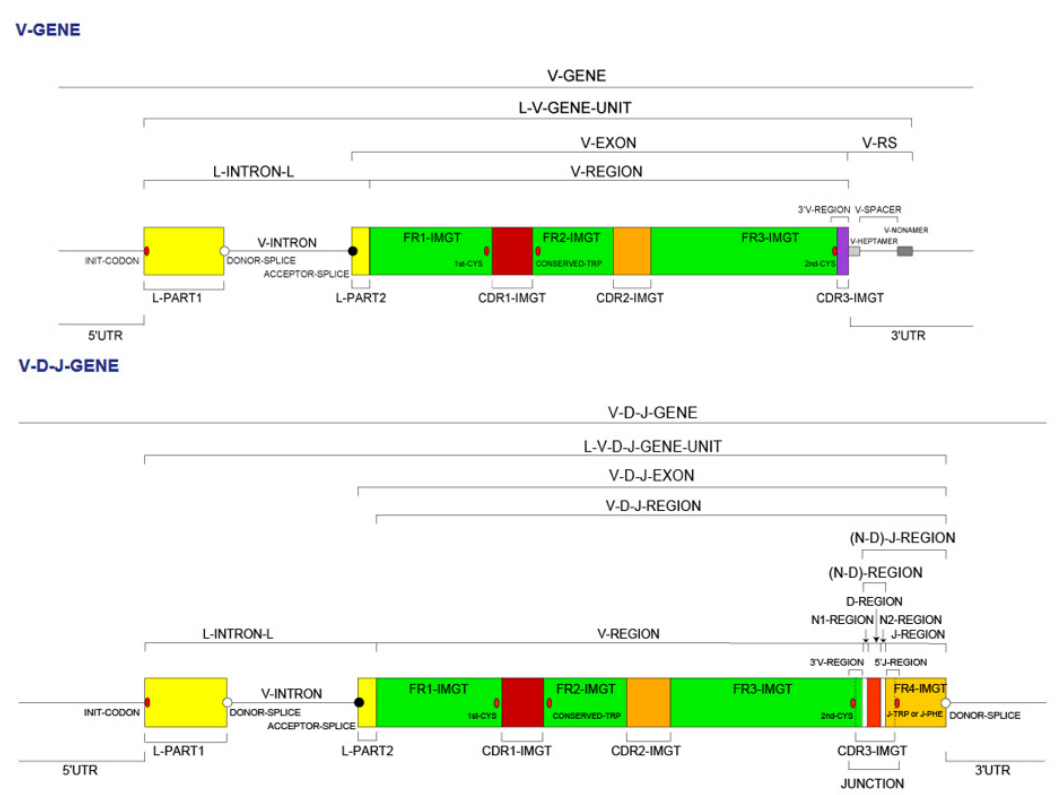
Figure 14. Description of a V ‐ GENE and of a V ‐ D ‐ J ‐ GENE (DESCRIPTION axiom) [34,35]. IMGT standardized labels [32–34], generated from the concepts of description, are in capital letters (no plural), e.g., V ‐ REGION, JUNCTION, CDR ‐ IMGT [32], FR ‐ IMGT [33]. Forty labels (27 for V ‐ GENE and 33 for V ‐ D ‐ J ‐ GENE of which 20 are shared) are necessary and sufficient for a complete description. The labels for the description of genomic rearranged genes in IMGT/LIGM ‐ DB [54,55] are L ‐ V ‐ J ‐ GENE and L ‐ V ‐ D ‐ J ‐ GENE. The labels “GENE ‐ UNIT” have been created to bridge the DESCRIPTION and CLASSIFICATION axioms. Indeed they refer to genomic entities, in germline (for V, D and J) or undefined (for C) configuration, entered in IMGT/GENE ‐ DB [56]. Exceptionally they may refer to rearranged entities (as the L ‐ V ‐ D ‐ J ‐ GENE ‐ UNIT, shown here) when the corresponding germline genes are not yet known. (With permission from M ‐ P. Lefranc and G. Lefranc, LIGM, Founders and Authors of IMGT ® , the international ImMunoGeneTics information system ® , http://www.imgt.org).